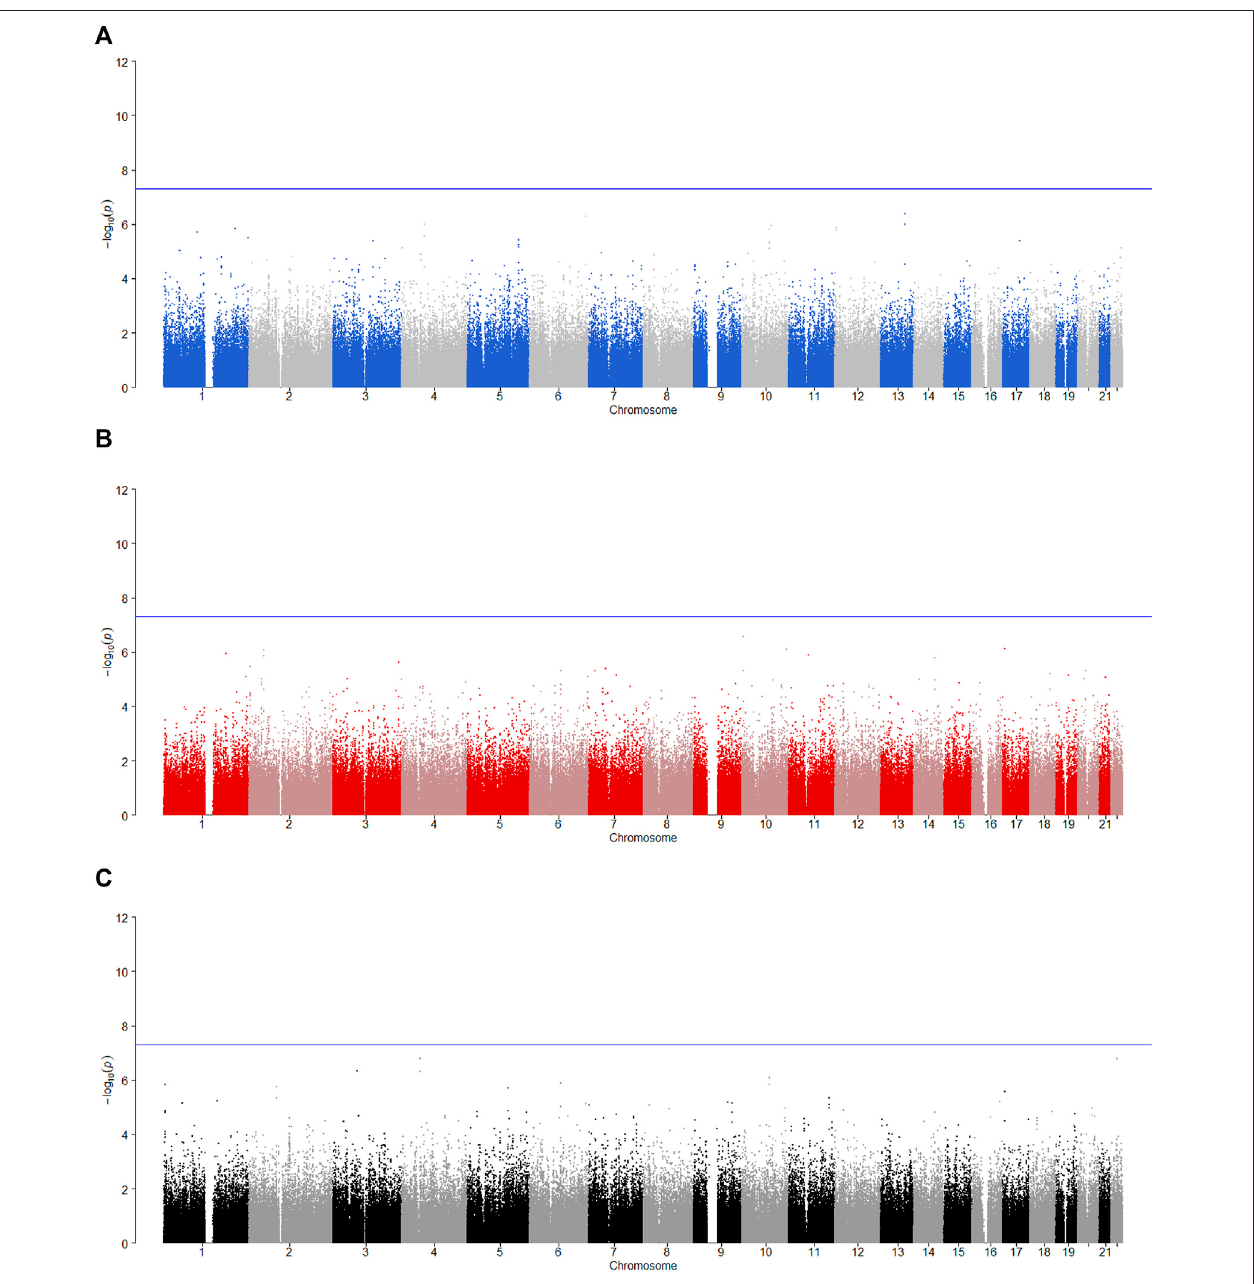
FIGURE 5 | Manhattan plot for POE and genotypic effect tests of illicit drugs ( N = 2,185). The blue line represents the signi fi cance level α (cid:1) 5 × 10 − 8 , which is the signi fi cance level of GWAS. (A) Paternally derived effect, (B) maternally derived effect and (C) genotypic effect.